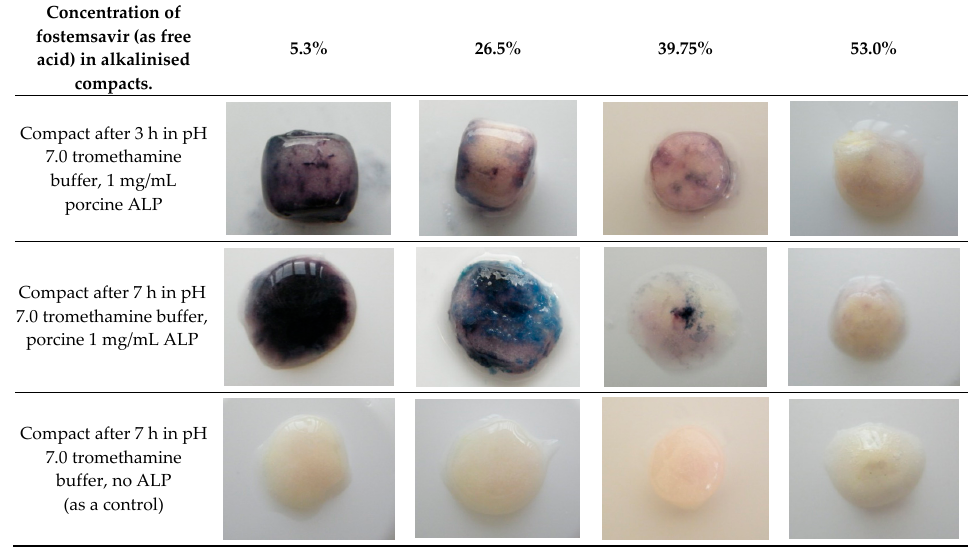
Figure 7. Hydrated compacts containing various concentrations of fostemsavir, pH-adjusted with tromethamine.